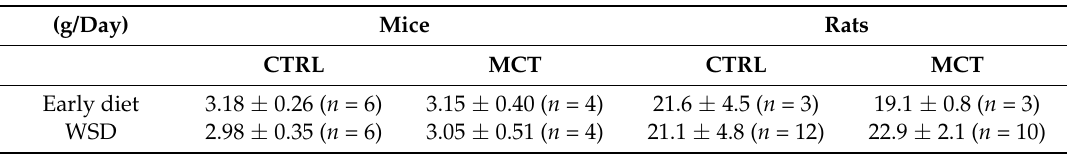
Figure 3. Rat study Development of body weight (BW), lean body mass (LBM), fat mass (FM), and relative fat mass (%BW) during the WSD challenge (PN 43–98) of male rats (panels ( A – D ), respectively) fed a CTRL ( n = 9) or MCT diet ( n = 7) in early life (PN day 2–42). Values are means ± SD. Table 2. Mean food intake (g/day) during early diet (on PN day 42) and during WSD intervention (on PN day 84) 1 .